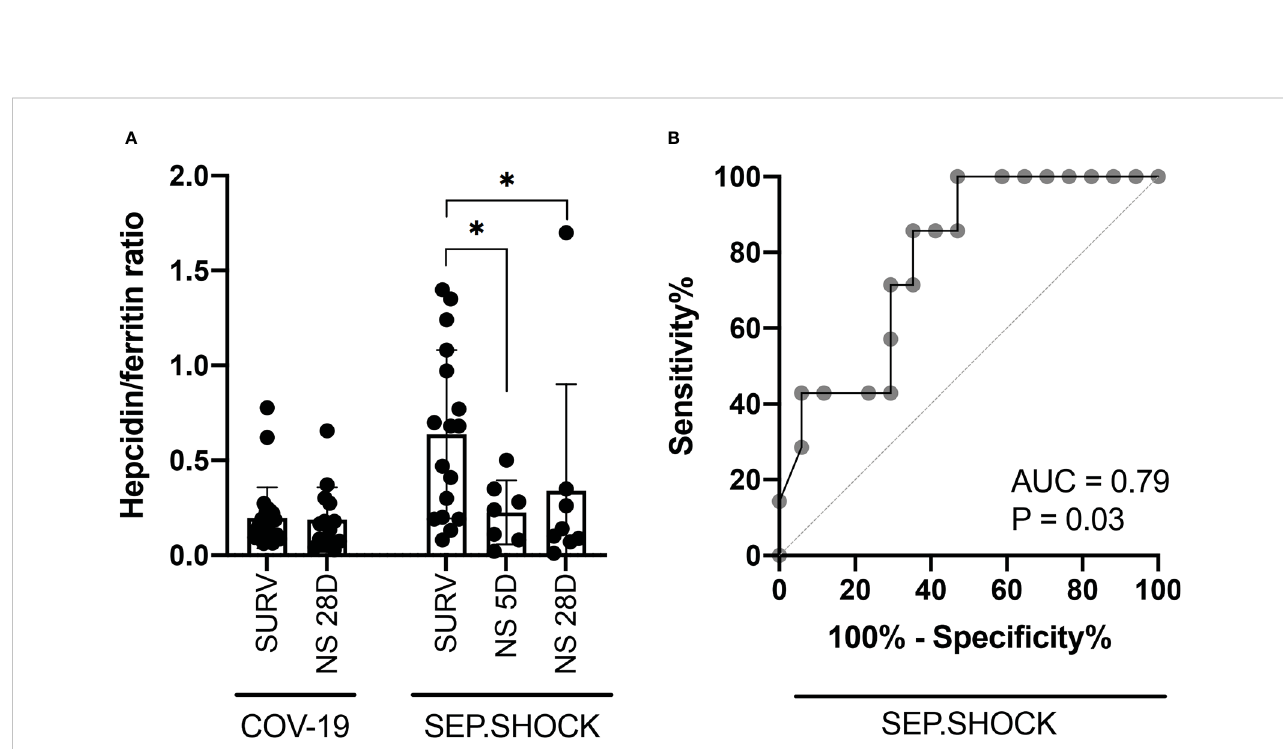
FIGURE 3 The hepcidin-to-ferritin ratio is a potential marker for strati fi cation of septic shock patients. (A) The TP1 hepcidin-to-ferritin ratio was signi fi cantly lower in the 5D and 28D mortality groups in comparison to survivors in the septic shock cohort. (B) ROC curve analysis was performed to evaluate the diagnostic potential of the hepcidin-to-ferritin ratio for predicting overall mortality in septic shock patients. The resulting AUC was 0.79, indicating a predictive potential. Statistical comparisons were performed using the Mann-Whitney test. AUC, area under the curve; NS, non-survivor; ROC, receiver operating characteristic; SURV, survivor. * P < 0.05.